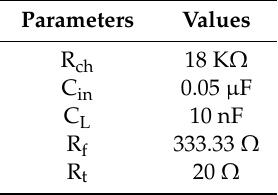
Table 2. Parameters for chopped lightning impulse generator